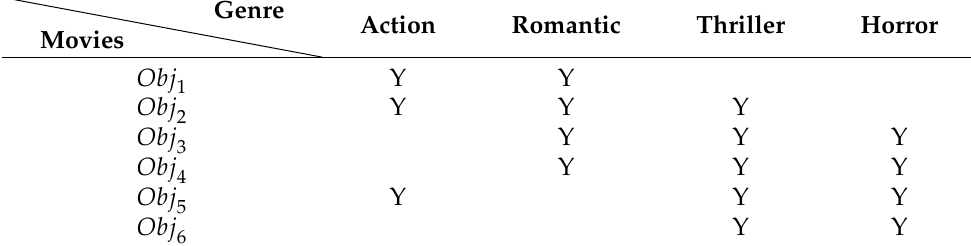
Table 2. Details of